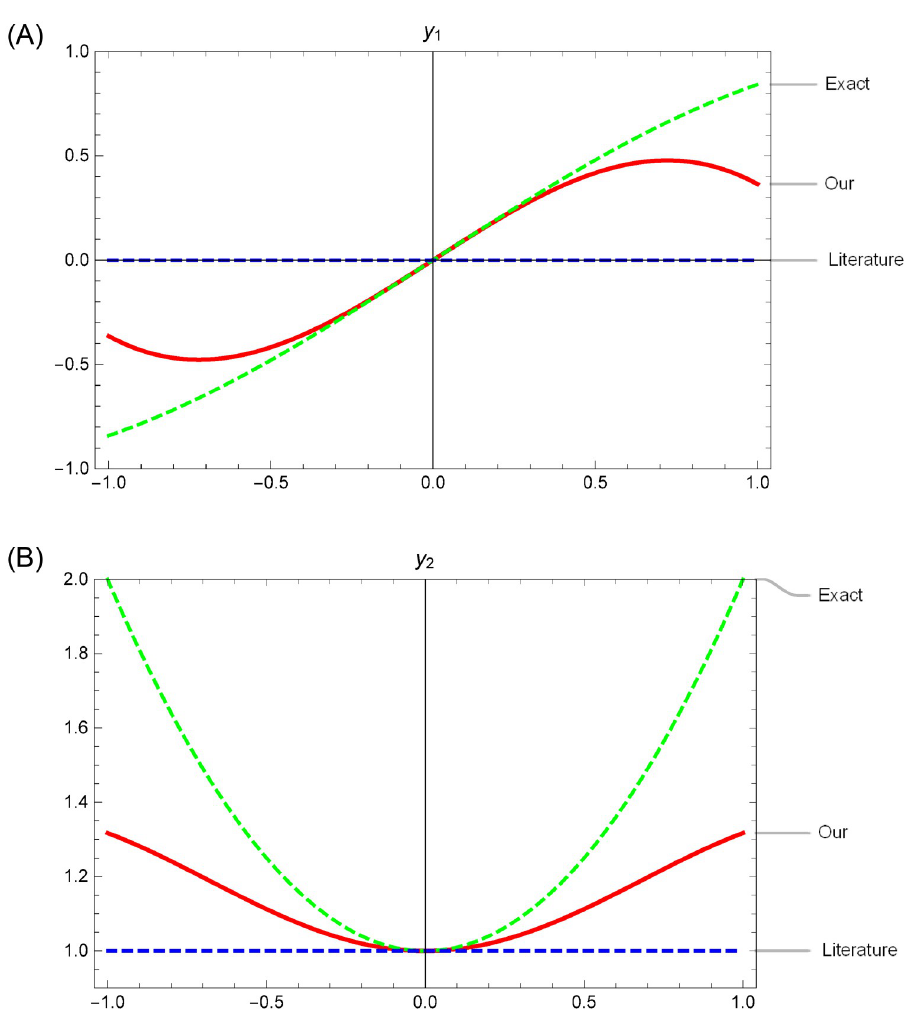
Fig 1. Comparison of the efficiencies of the first terms � y in an interval of x = 0 in Example 1. A:Comparison of � y the initial point t =